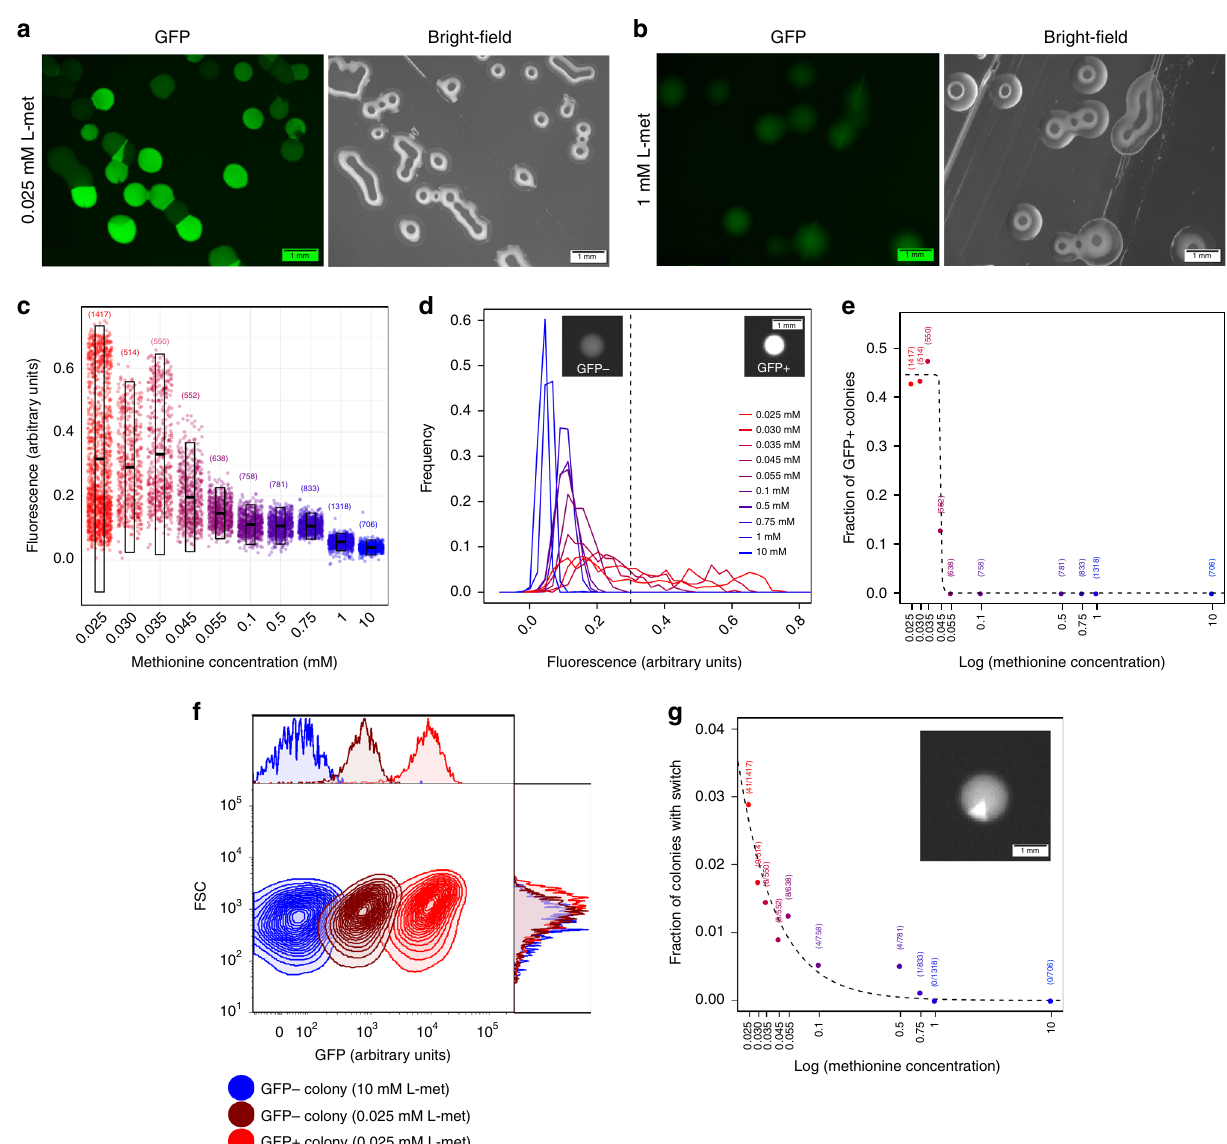
Fig. 2 The phenotypic heterogeneity at the colony level. L. lactis colonies grown for 48 h on CDM-agar plates with either, a , low (0.025 mM) or, b high (1 mM) methionine concentrations. a , b left image shows green- fl uorescence channel and right image shows bright- fi eld channel. Scale bars, 1 mm. c Mean fl uorescence intensities of individual colonies grown on CDM-agar plates at different methionine concentrations (0.025 – 0 mM, red to blue; see also Supplementary Figs. 2, 3). Transparent boxes show mean and standard deviation, and number between parentheses shows number of analyzed colonies. d Distribution of mean fl uorescence intensities across colonies for different methionine concentrations (0.025 – 10 mM, red to blue). Vertical dotted line demarcates colonies categorized as having low met expression (GFP − ) or high met expression (GFP + ). Scale bar, 1 mm, e Fraction of GFP + colonies at different methionine concentrations. Dotted line shows fi t of step function ( y = a-a /(1 + e − 100·( x + b ) ); a = 0.450 ± 0.007 (s.e.), P a < 10 − 10 , b = 3.110 ± 0.001, P b < 10 − 16 ). f Fluorescence measurements by fl ow cytometry show the met expression in each type of colony phenotype: GFP + colony (light-red) grown on low methionine concentrations (0.025 mM), GFP − colony (dark-red) grown on low methionine concentrations (0.025 mM), and GFP − colony (blue) grown on high methionine concentrations (10 mM). 10,000 ungated events for each sample are shown. g Switching rate at different methionine concentrations (0.025 mM to 10 mM, red to blue). Inset shows example of colony with switch in expression level. Numbers in parenthesis show number of colonies with expression switch and total number of analyzed colonies. Dotted line shows exponential fi t ( y = e − a ·( x – b ); a = 1.34 ± 0.27 (s.e.), P a < 0.01; b = 6.41 ± 0.61, P b < 10 − 5 ). Scale bar, 1 mm. Source data are provided as a Source Data fi